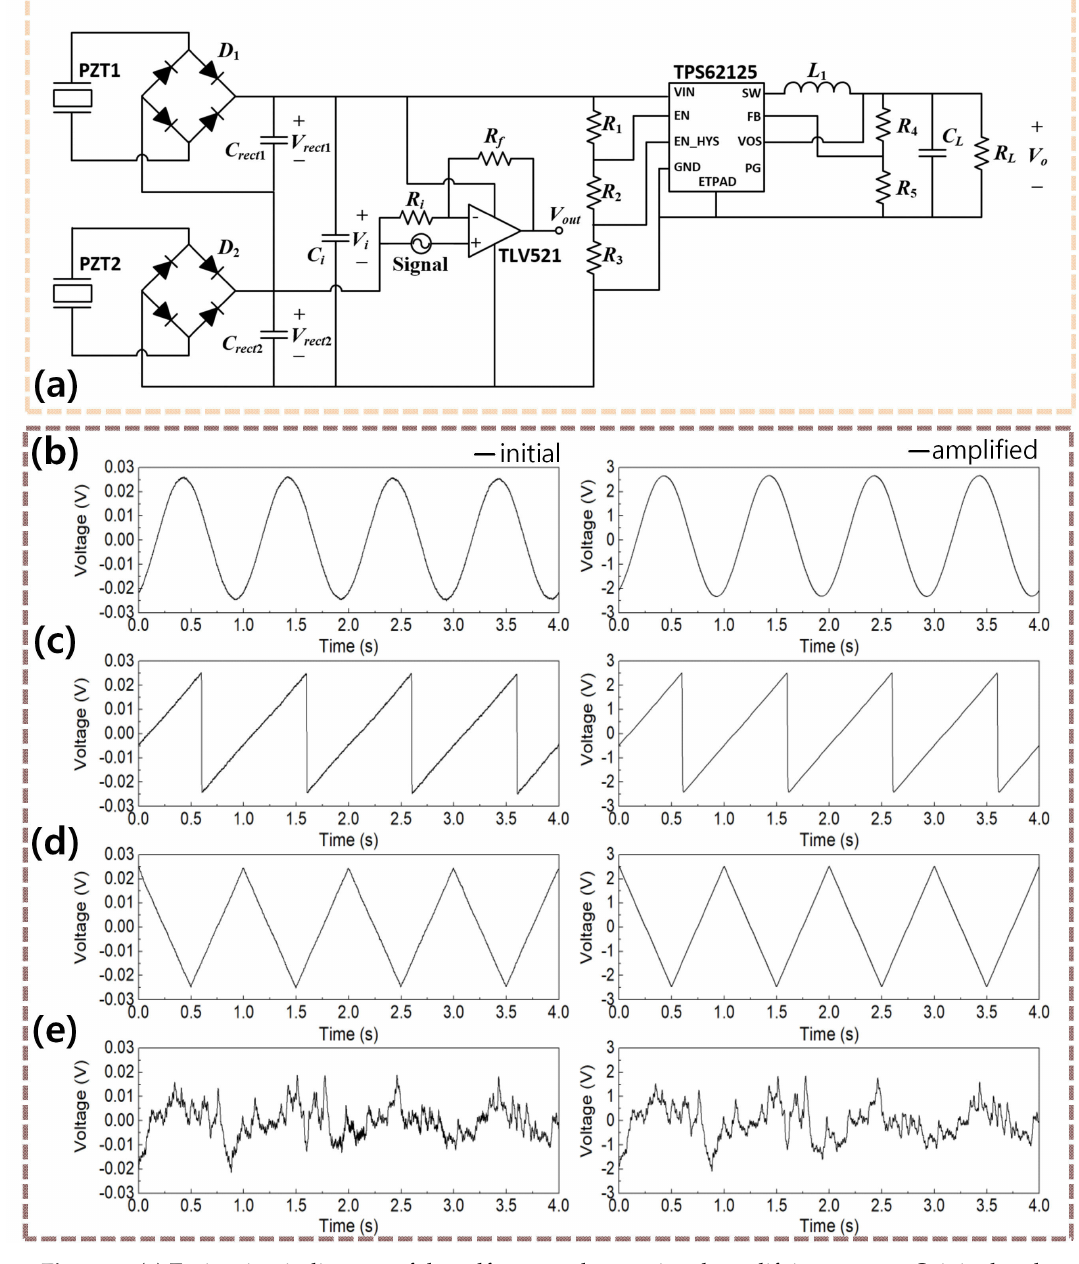
Figure 7. ( a ) Entire circuit diagram of the self-powered operational amplifying system. Original and amplified signals: ( b ) Sine, ( c ) saw-tooth, ( d ) triangle, and ( e ) random assuming real environments (sound, earthquake, sonar